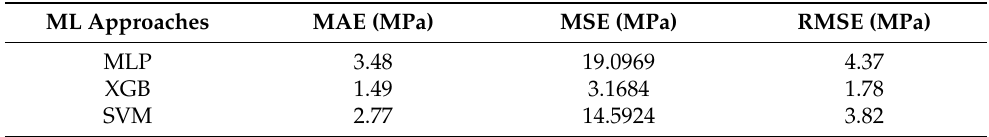
Table 2. Statistical measures of the employed